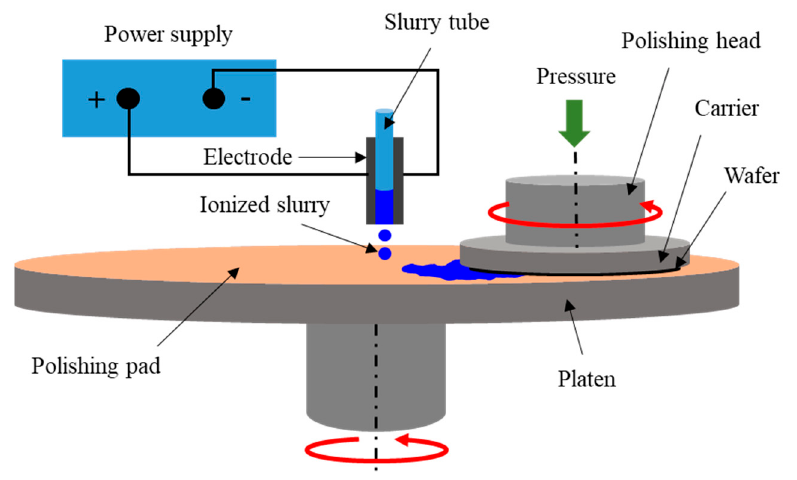
Figure 1. Schematic of an electrolytically ionized CMP system.